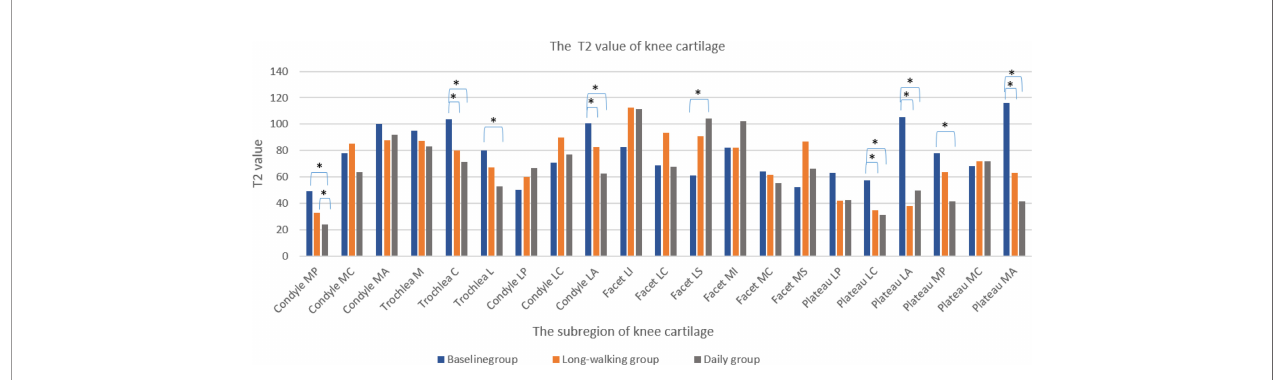
FIGURE 7 | Changes in T2 values of knee cartilage in each sub-region in the three groups. * Indicates statistical signi fi